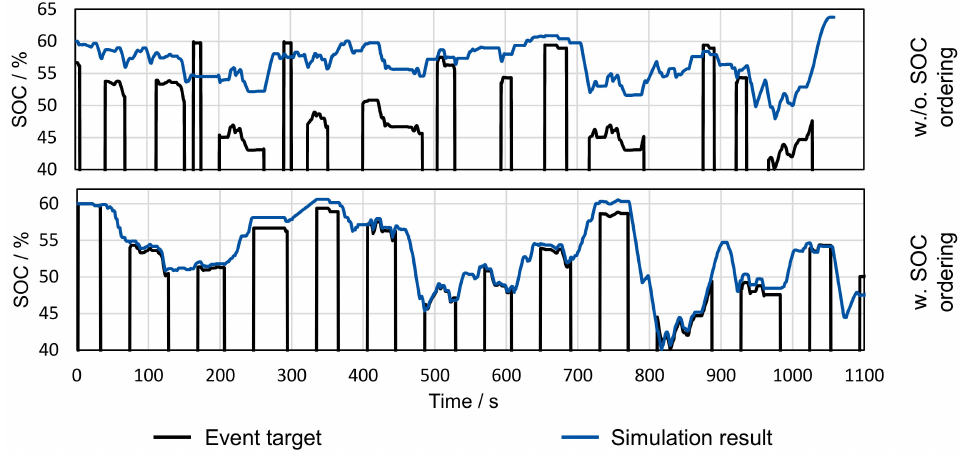
Figure 12. Comparison of SOC deviation for randomly placed events and SOC ordered